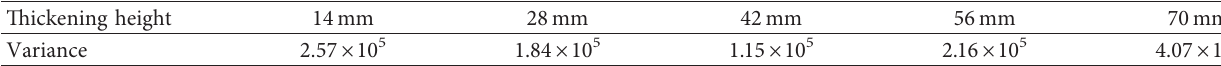
Table 1: Variance results of the load-displacement curve of the device with different thicknesses.